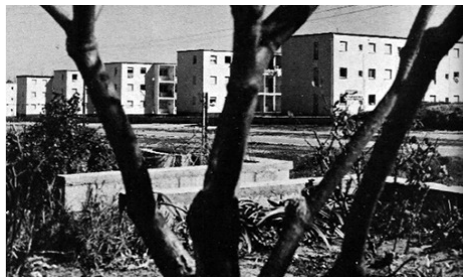
Figure 4. Zeilenbau condominiums in Netanya. Source: Ministry of Housing (1964).